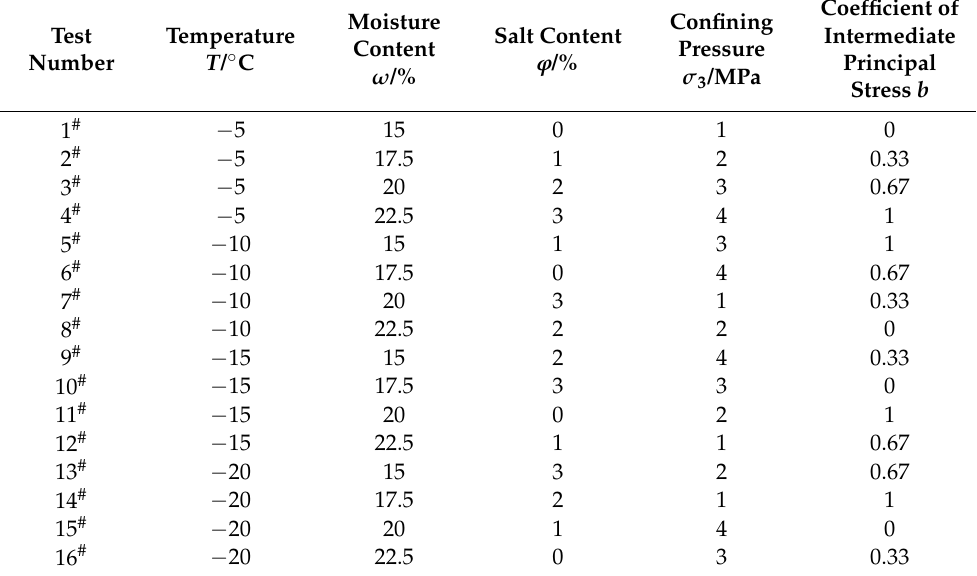
Table 3. Plan of true triaxial